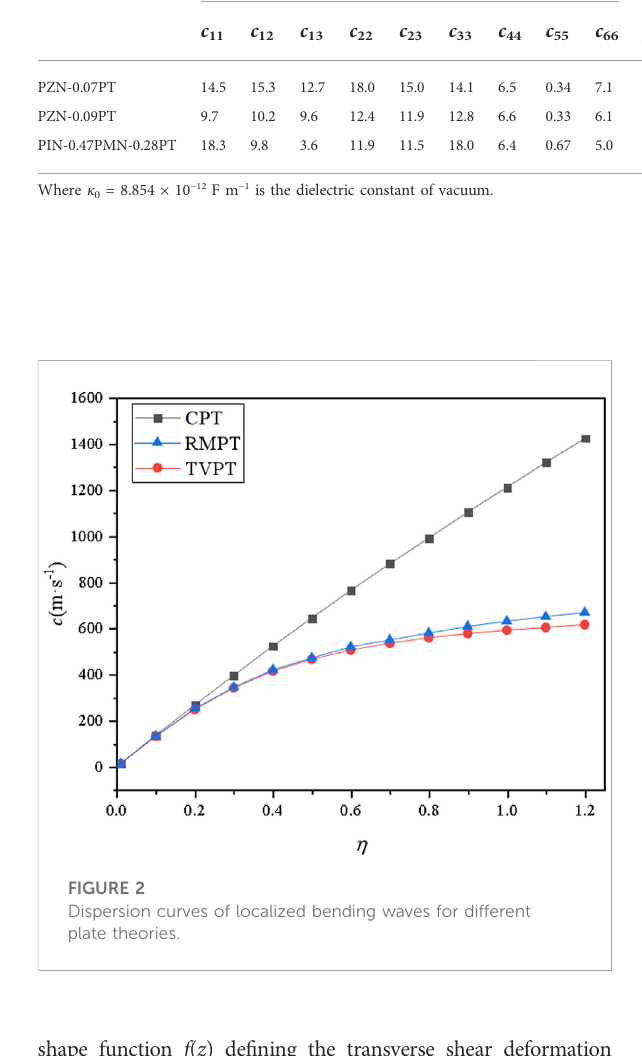
TABLE 1 Material constants used in the numerical examples. Materials